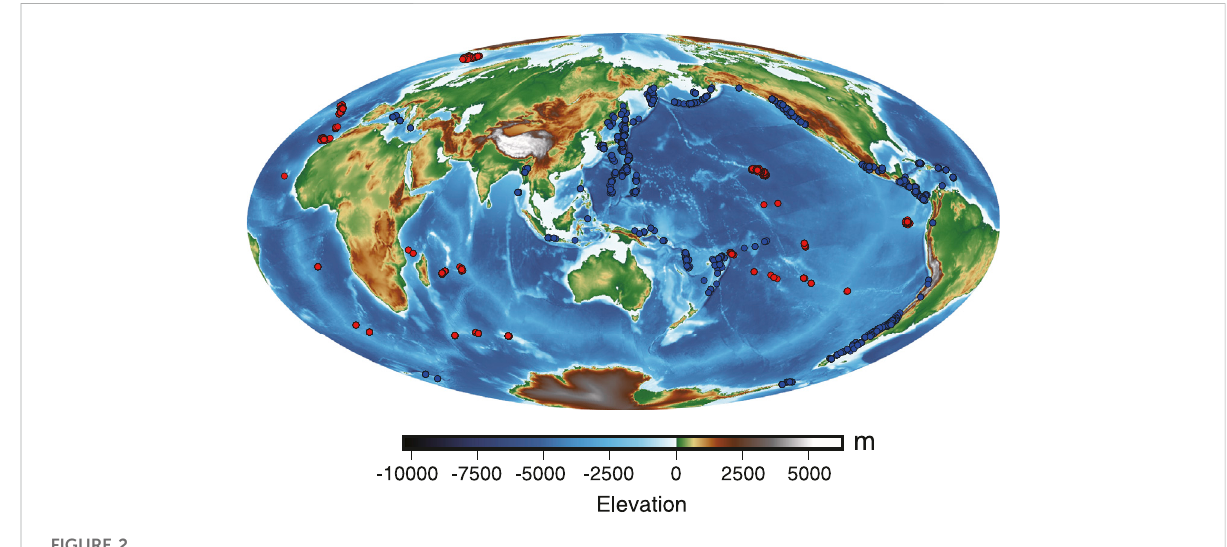
FIGURE 2 Geological map showing the locations of IAB (blue circles) and OIB (red circles) samples used during this study. Map created with open source PyGMT Python module (Uieda et al., 2021).